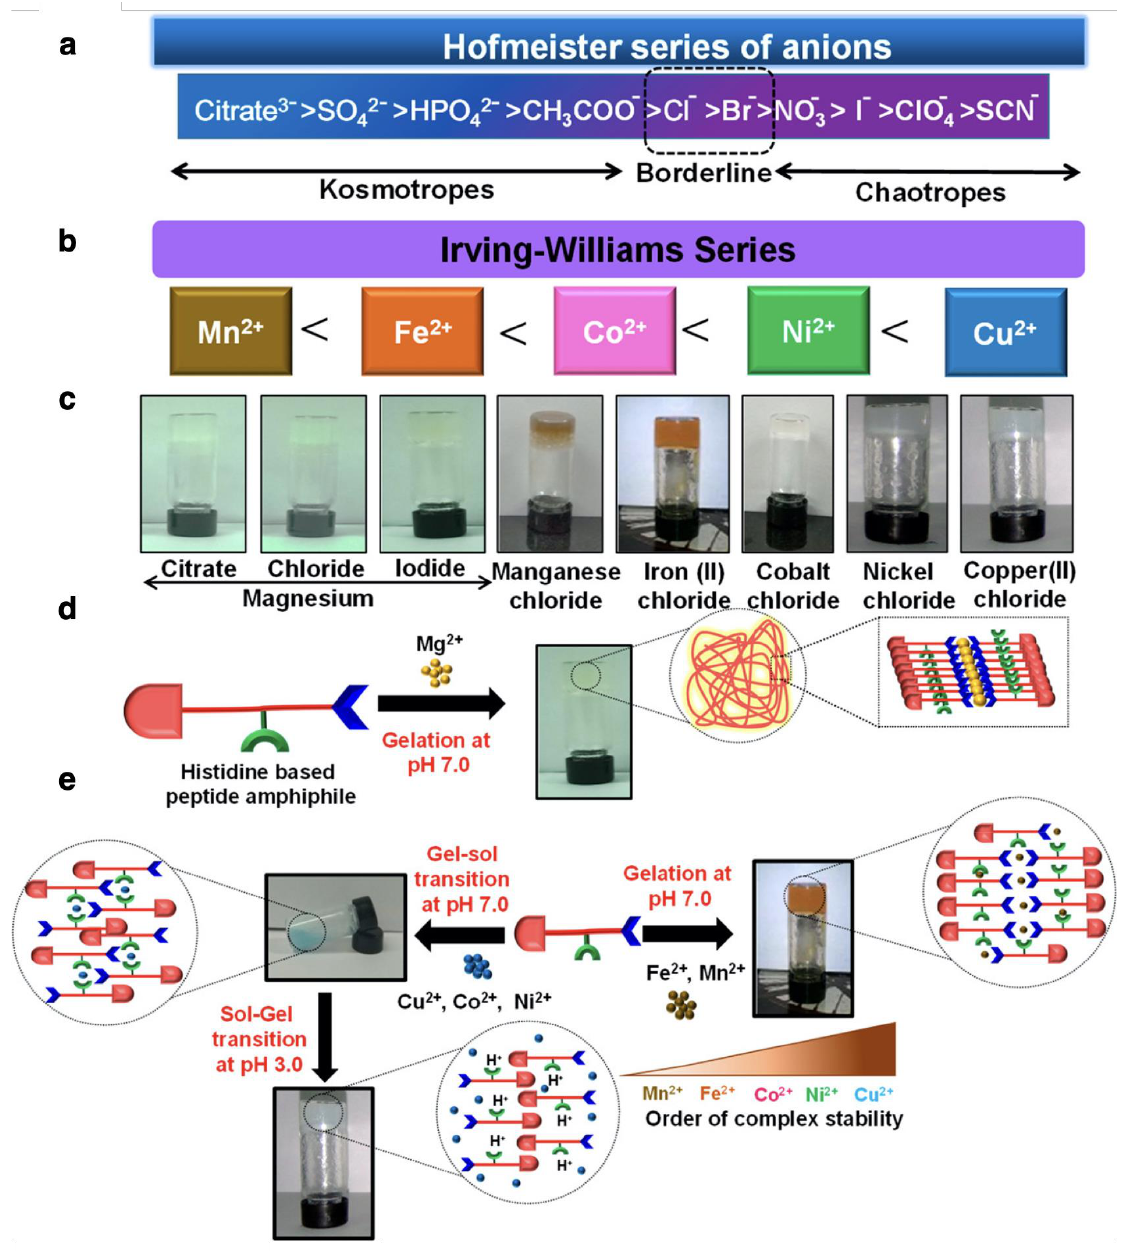
Figure 5. Schematic representation showing ( a ) Hofmeister series of anions, ( b ) Irving – Williams series depicting the order of stability of metal – ligand complexes. ( c ) Optical images of the peptide hydrogels of Fmoc – HL – COOH formed in the presence of metal salts at different pH. Scheme representing the variation in self-assembling behavior of histidine-based peptide amphiphile in the presence of ( d ) magnesium salts and ( e ) transition metal salts. Reprinted with permission from ref 38. Copyright 2019 American Chemical Society.